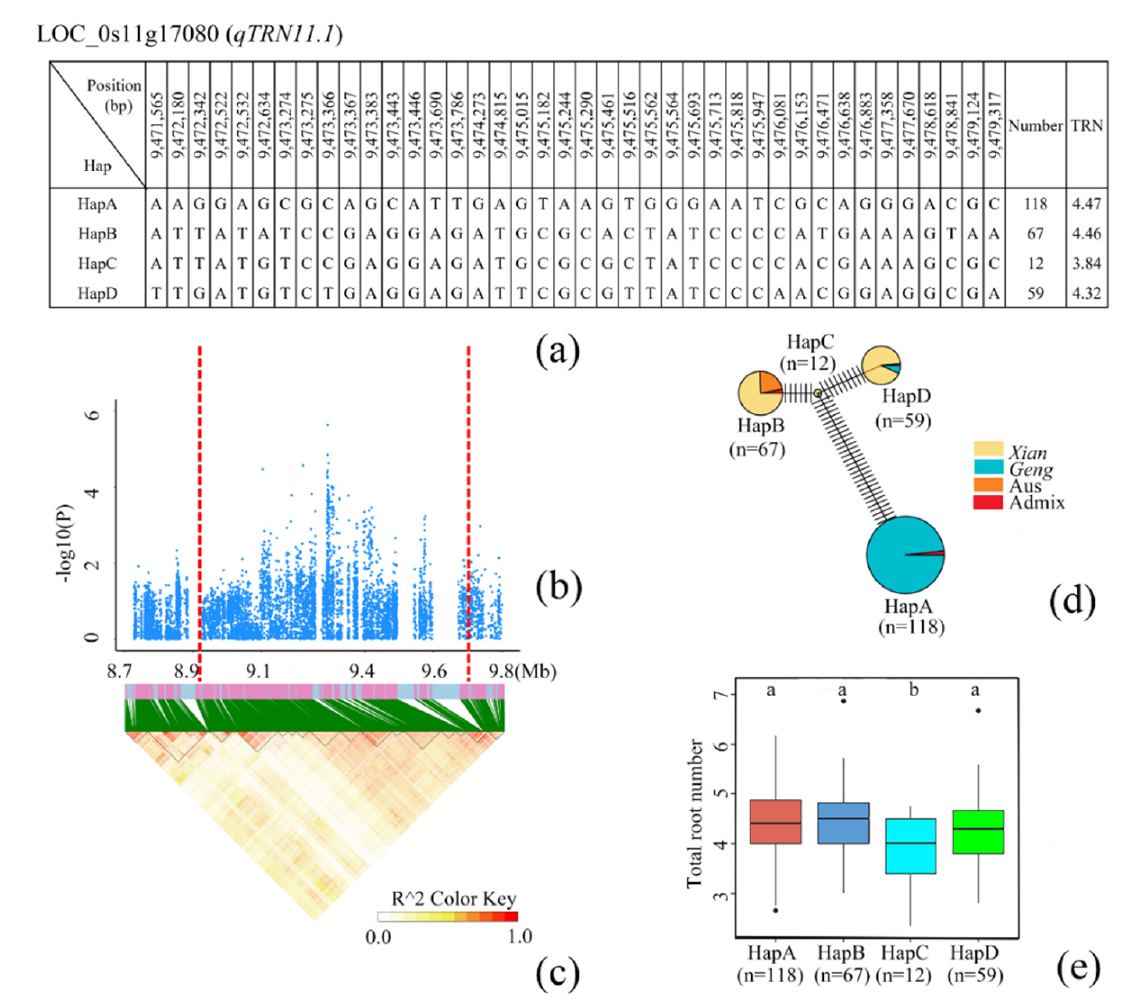
Figure 5. Identification of candidate genes for TRN. ( a ) Based on 40 SNPs observed in all evaluated rice accessions, four haplotypes of OsMPK15 (LOC_Os11g17080) were identified. In the gene structure diagram of OsMPK15, the promoter is indicated by white frame; the exon is represented by blue frame; and the intron and intergenic regions are marked by black lines. A thin black line represents